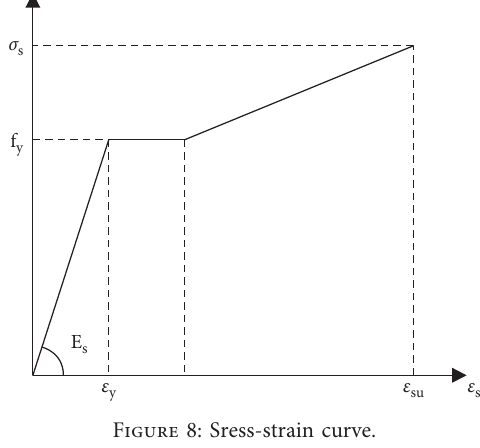
Figure 8: Sress-strain curve.